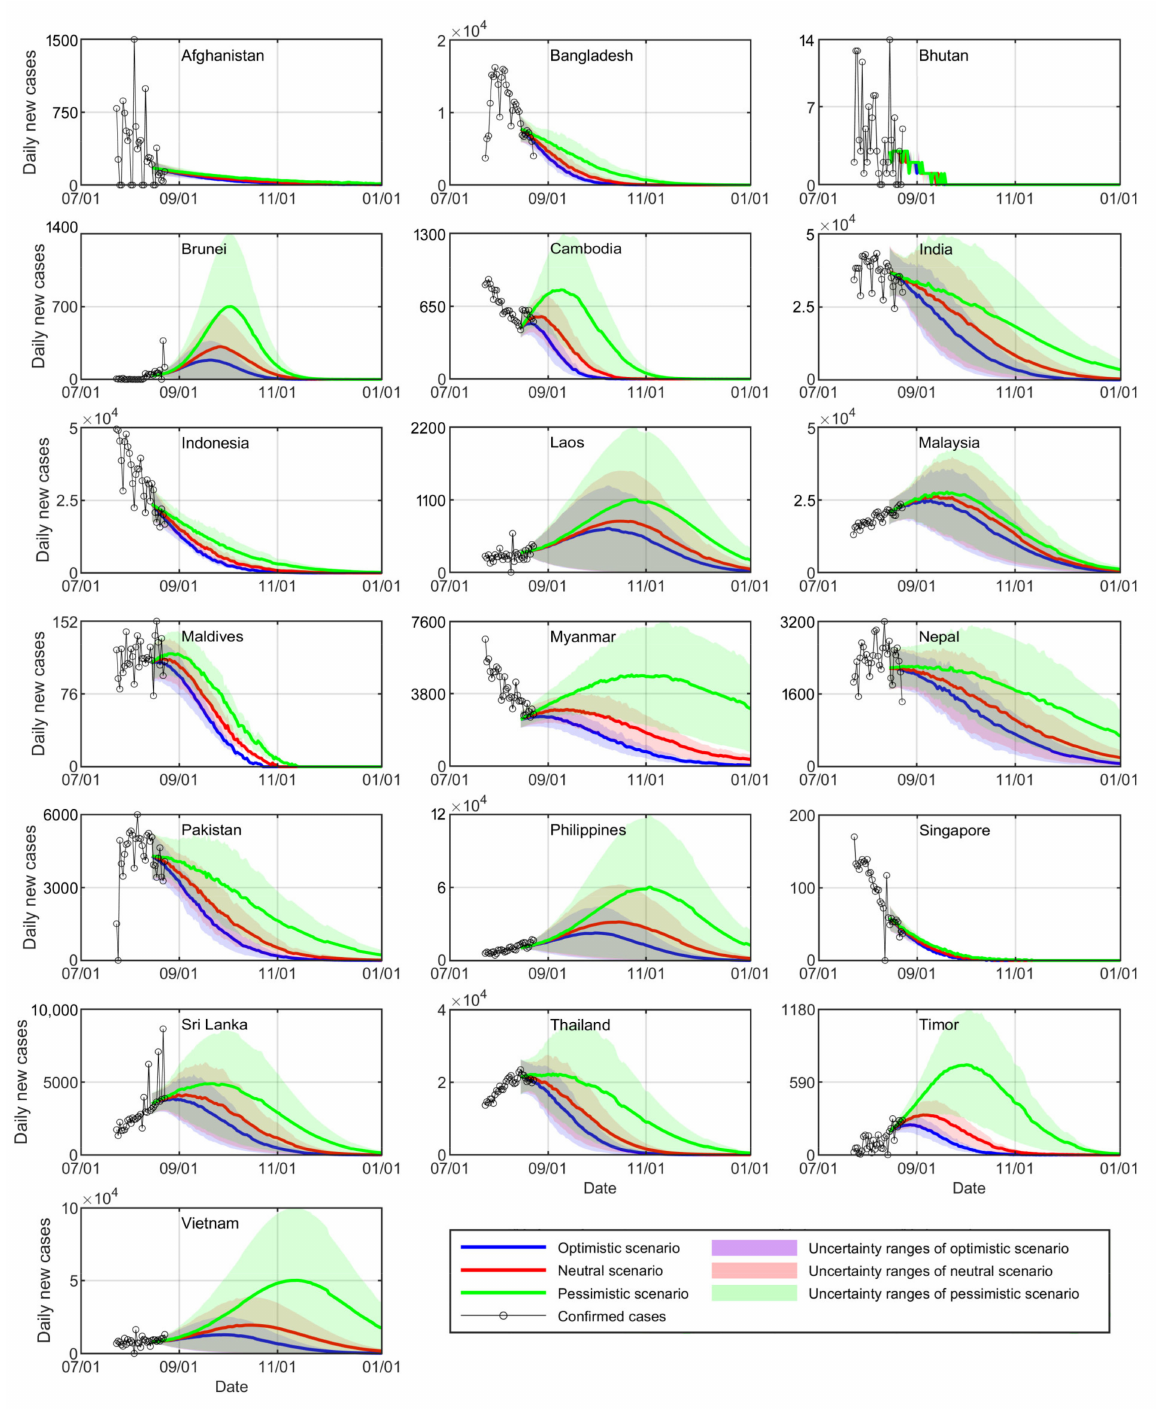
Figure 4. Predicted daily new cases in 19 countries in South and Southeast Asia in three scenarios (optimistic scenario: 1.5 times the current protection rate. Neutral scenario: current protection rate. Pessimistic scenario: 0.5 times the current protection